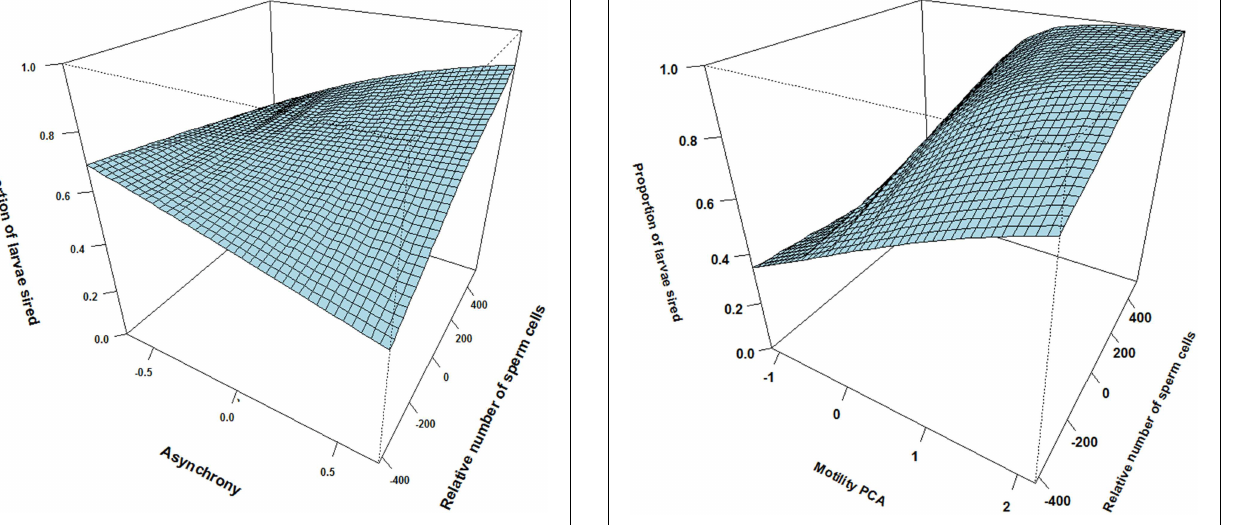
FIGURE 2 | The interaction between relative motility PCA (i.e., per cent motile sperm cells and sperm velocity in water and ovarian fluid) and relative number of sperm cells on proportion of larvae sired for the males that ejaculated in synchrony (simultaneously). When the two males have similar sperm numbers there is a sharp increase in paternity with increasing difference in motility PCA. At similar motility PCA there is also a slight increase in paternity with increasing difference in sperm